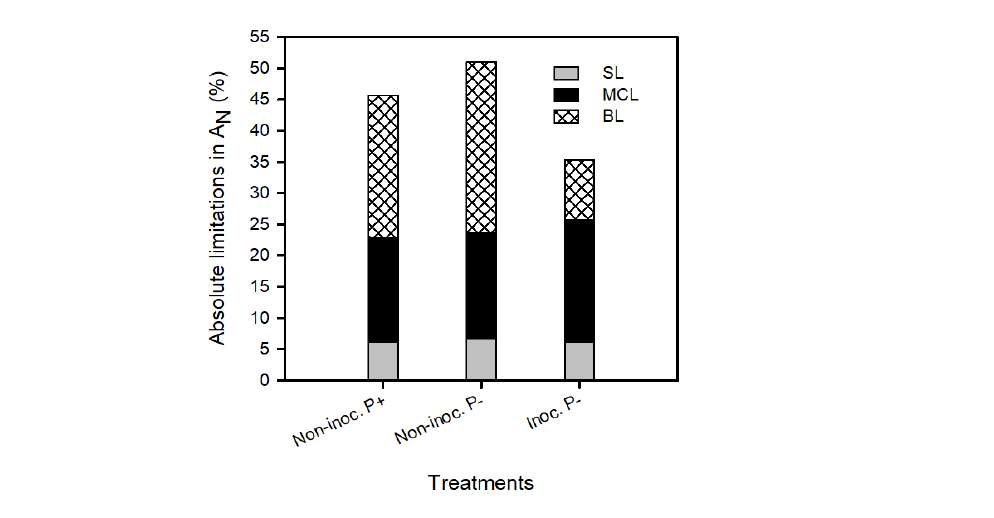
the non-inoculated plants, with 27 and 23% of total limitations in plants fertilized without and with an insoluble phosphorus form, respectively (Figure 3).